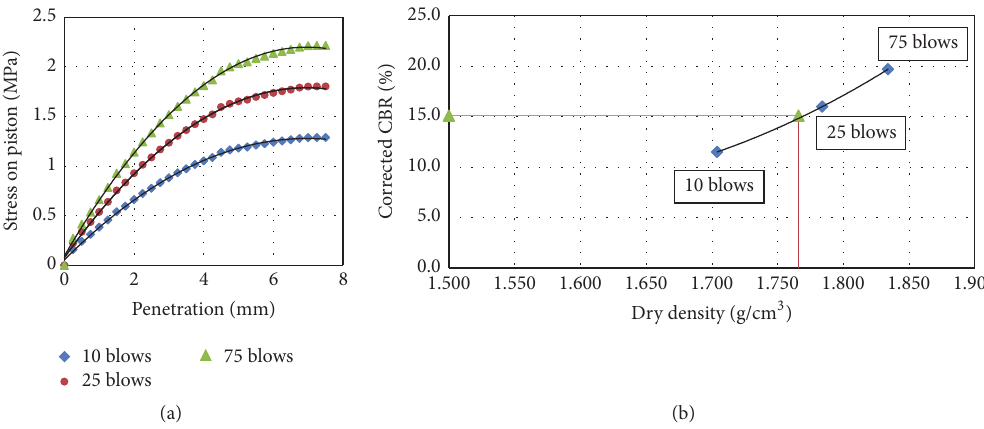
Figure 12: (a) Relationship between resistance and penetration for soil with 25% FSSA additives. (b) CBR value for soil with 25% FSSA